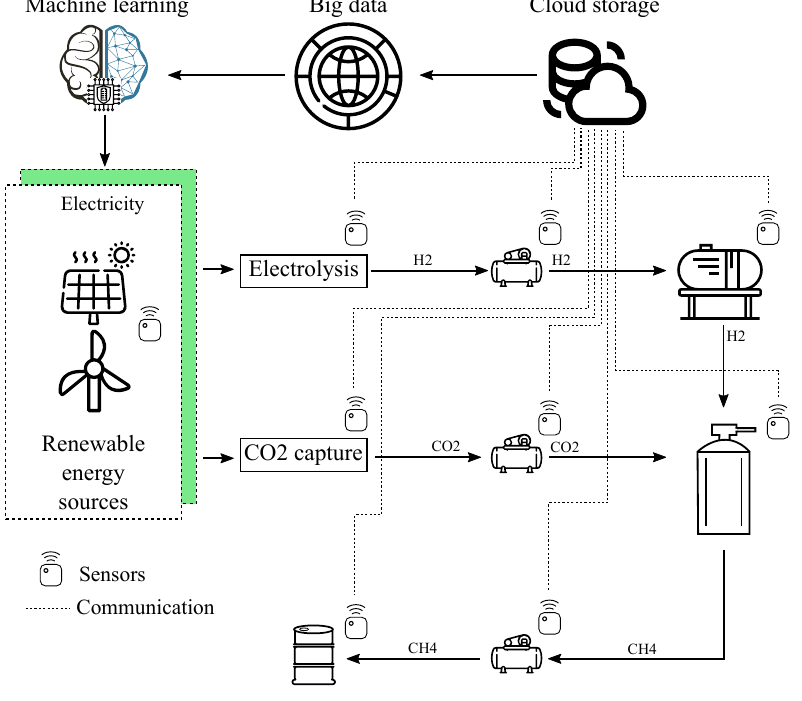
Figure 5. Methanol synthesis